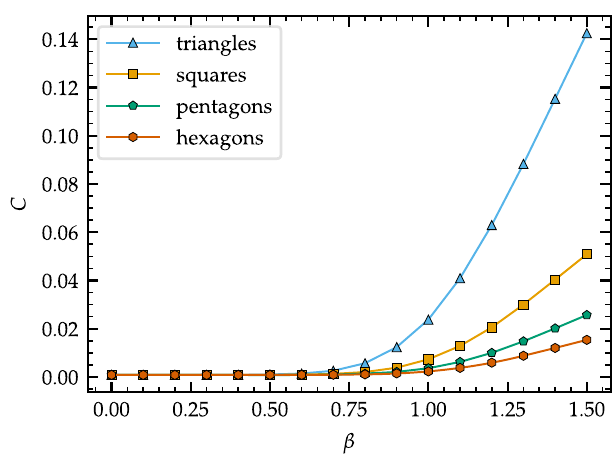
Fig. 2 The global clustering coef fi cient for different sized chordless cycles as a function of the inverse temperature. The global clustering coef fi cient is de fi ned as the ratio between the amount of closed n -lets and the total amount of n -lets, where n goes from three (triangles) to six (hexagons). This coef fi cient is a measure for the amount of different sized chordless cycles, as a function of the inverse temperature β . The results shown are for networks of size N = 5000 and 〈 k 〉 = 6. Error bars representing the standard error are smaller than the data points and therefore not